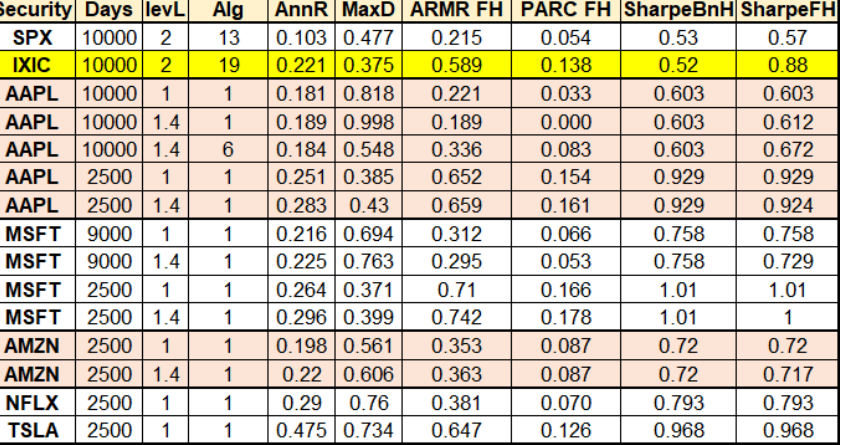
Figure 14. Tabular representation of key findings of this paper, showing the performance of all tested financial variables over long time horizons, and quantified using a variety of metrics, including the ARM Ratio, the PARC Measure, and the Sharpe Ratio. This table provides strong evidence that both the ARMR and PARC outperform the Sharpe Ratio, with PARC taking the top spot, as useful metrics for investment decisions. Tellingly, even when the leveraged AAPL stock has a 99.8% MaxD, Sharpe still gives it a fairly high score of 0.612, while ARMR downgrades it considerably to 0.189, and PARC grades it simply as 0.000, its minimum score. Among investments that were tested for long periods (9 K–10 K days), our highlighted investment in IXIC performs best according to PARC (and visually has an excellent performance in Figure 9), and is thus our baseline strategy. More details of comparisons are provided in the